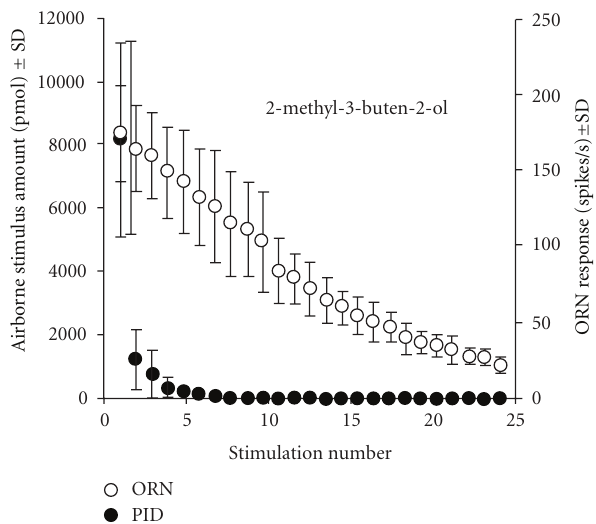
Figure 5: Response of Ips typographus olfactory receptor neurons (ORNs) and a photoionization detector (PID) to successive stimu- lations with 2-methyl-3-buten-2-ol ( N = 4) (modified from